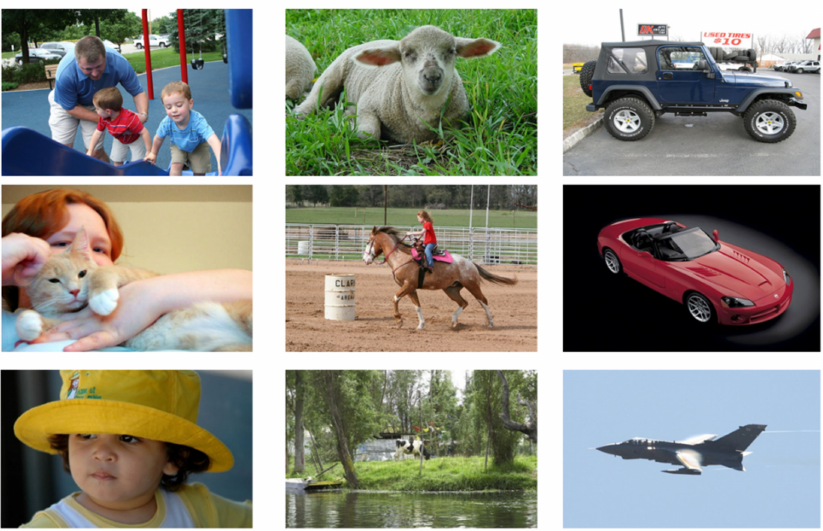
Figure 8. Image Samples of the VOC2008 Database [33].